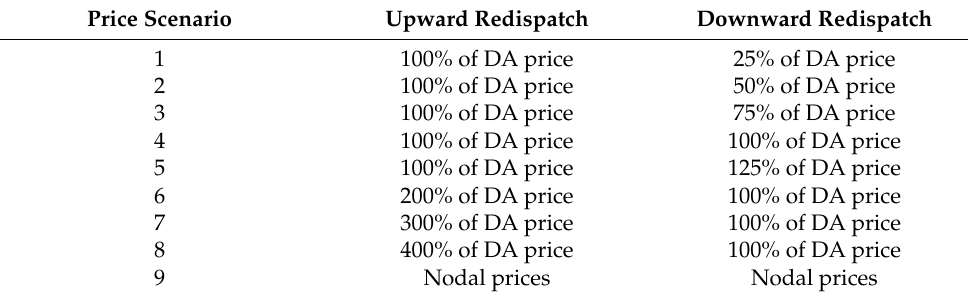
Table 2. Price scenarios (in comparison) used for